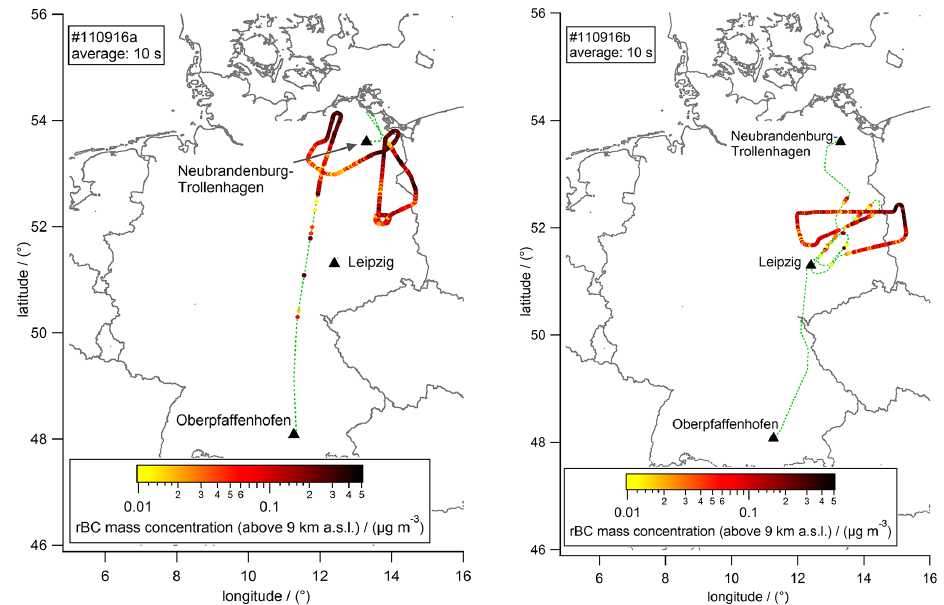
Figure 4. Flight tracks for flight #110916a (left) and #110916b (right) on 16 September 2011 with averaged (10s) rBC mass concentrations (STP) color-coded along the flight track. For clarity, only data for altitudes above 9kma.s.l. and rBC mass concentrations >0.01µgm − 3 are